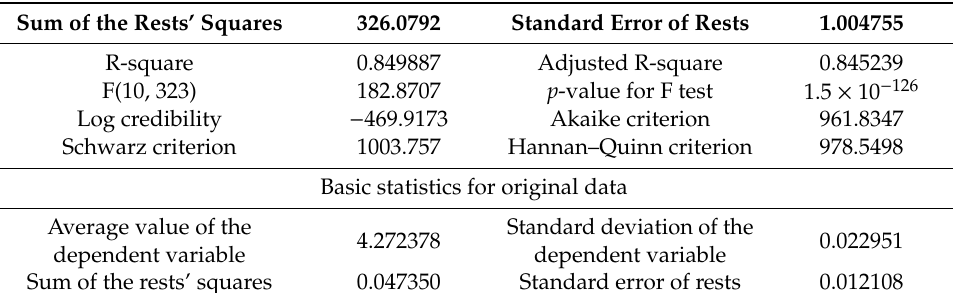
Table 7. Model 1 fitting measures (dependent variable LE(m) =